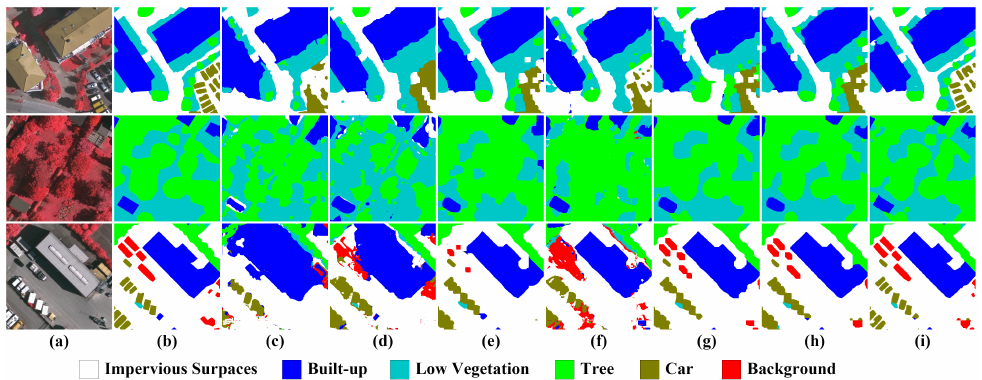
Figure 11. Comparison of segmentation results on the Vaihingen dataset. ( a ) Image; ( b ) Ground truth; ( c ) Baseline; ( d ) Baseline+SE; ( e ) Baseline+NLN; ( f ) Baseline+CBAM, ( g ) Baseline+DANet; ( h ) Baseline+ARM; and ( i ) XANet. Table 4. Accuracy comparison of different attention modules on the Vaihingen dataset. IS Building LV Tree Car mIoU baseline